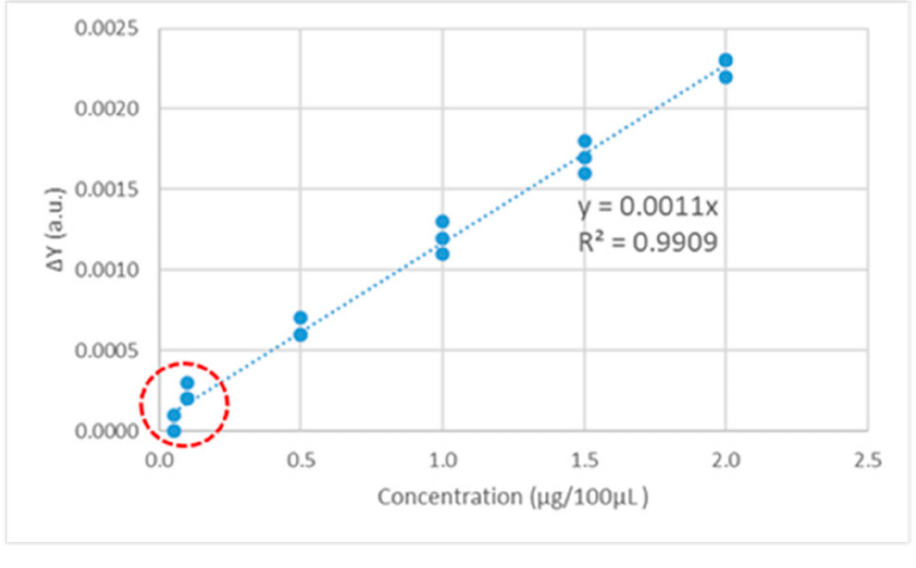
Figure 8. Relationship between the antigen concentration and ∆ Y by TeraPulse.